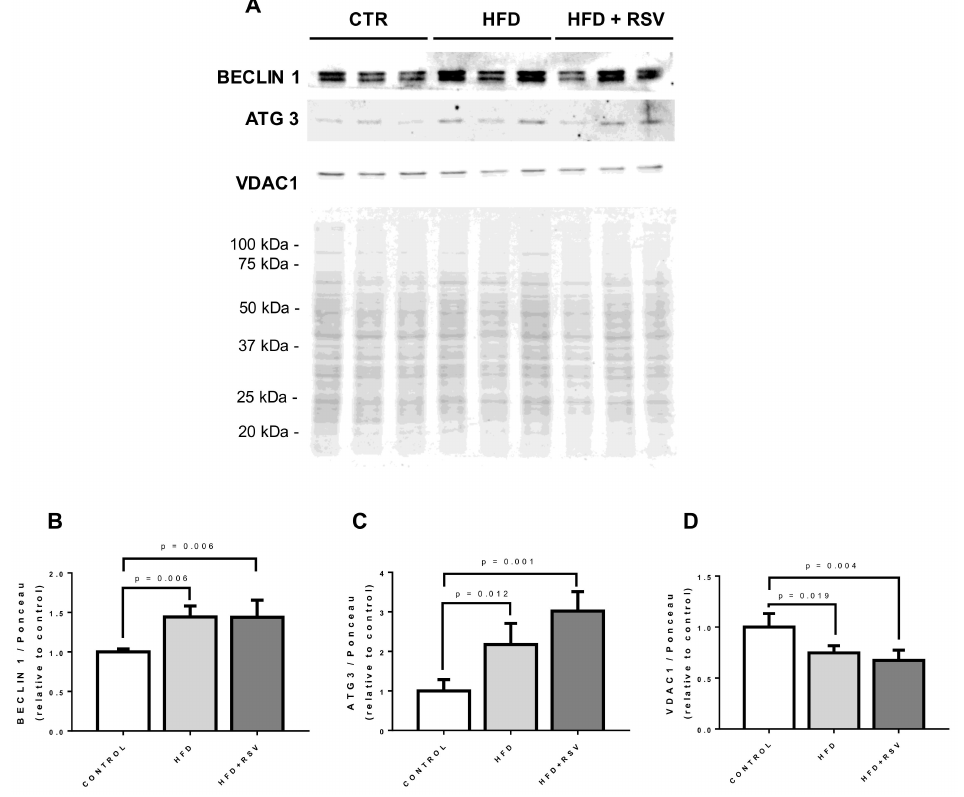
Figure7. Autophagymarkersinwholehomogenate. ( A )Representativewesternblottingsforautophagy markers in whole liver homogenates from three di ff erent animals per group. ( B – D ) Quantification of the proteins referred to Ponceau S as loading control (relative to control). Statistical significance is indicated in each figure ( n = 4). ATG3: ubiquitin-like-conjugating enzyme